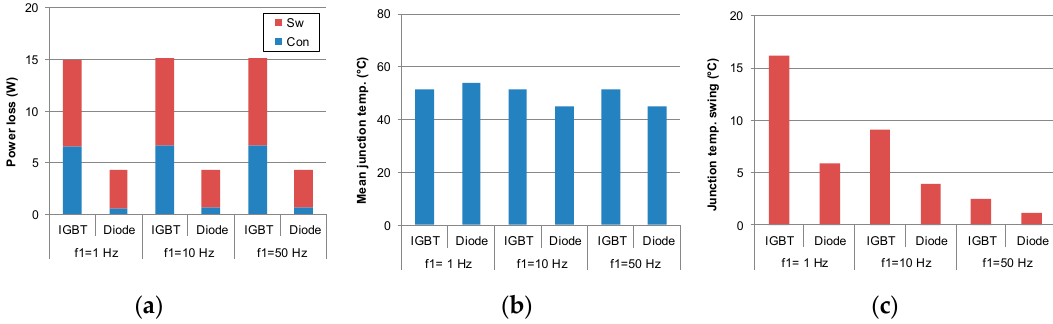
Figure 7. Impact of various fundamental frequencies (f 1 ) on power module. ( a ) Loss dissipation. ( b ) Mean junction temperature. ( c ) Junction temperature swing. Figure 8. Impacts of various switching frequencies ( f sw ) on power module. ( a ) Loss dissipation. ( b ) Mean junction temperature. ( c ) Junction temperature swing.